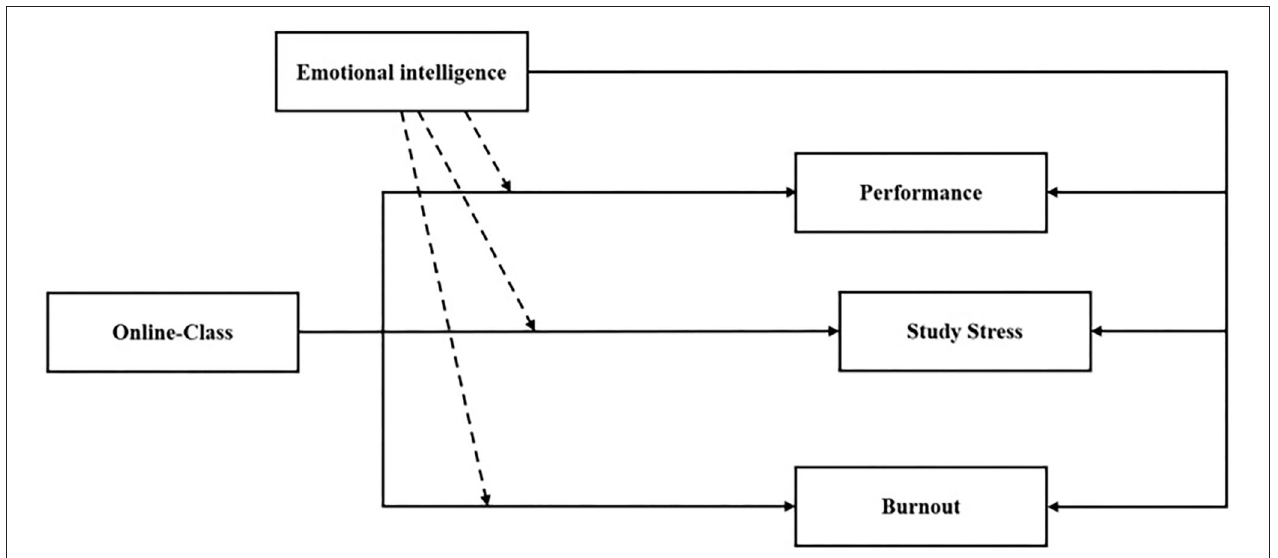
FIGURE 1 | Theoretical framework.